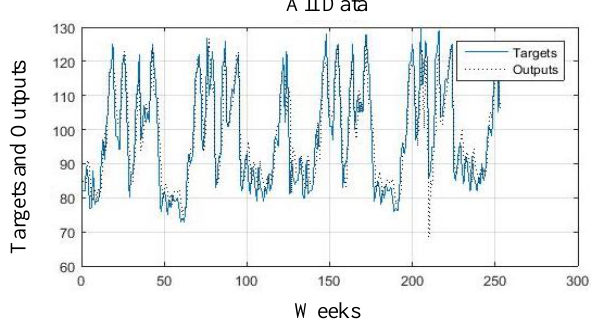
Fig. 9. Comparison of targets and outputs for GMDH model.